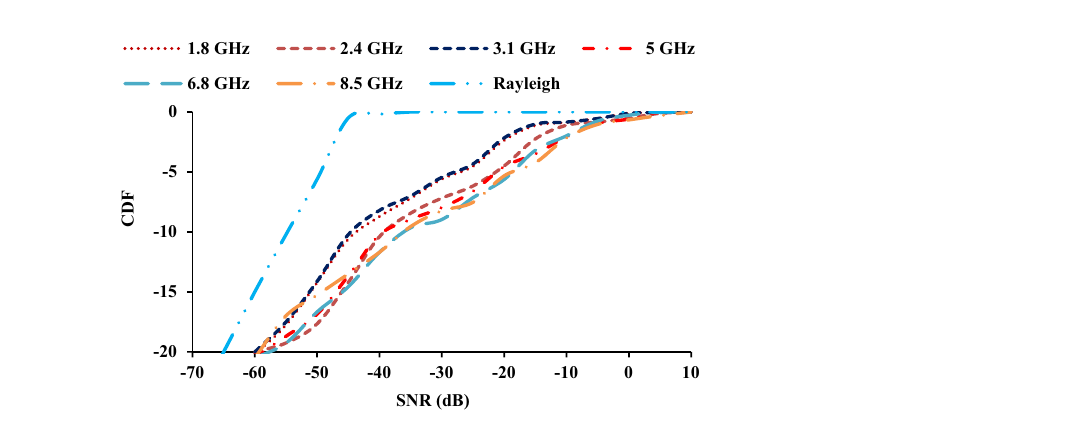
Figure 17. CDF of the twelve-port MIMO